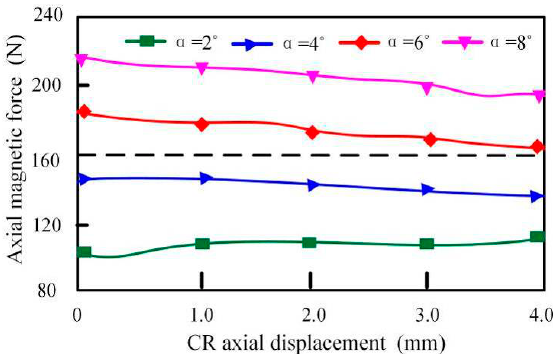
Figure 11. Relationship between the axial magnetic force and axial displacement at different cone angle.